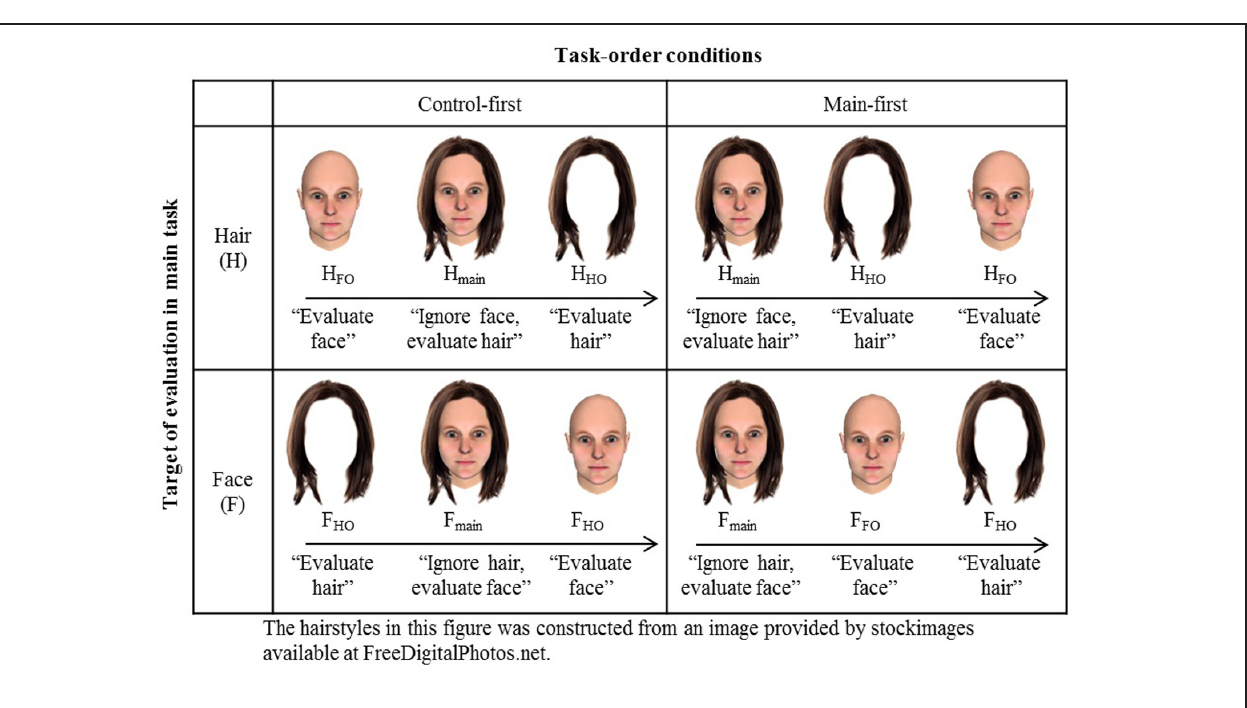
Participants were randomly assigned to two types of task order. Note that, in this figure, hairstyle is a sample image, similar to (but different from) the stimuli used in the